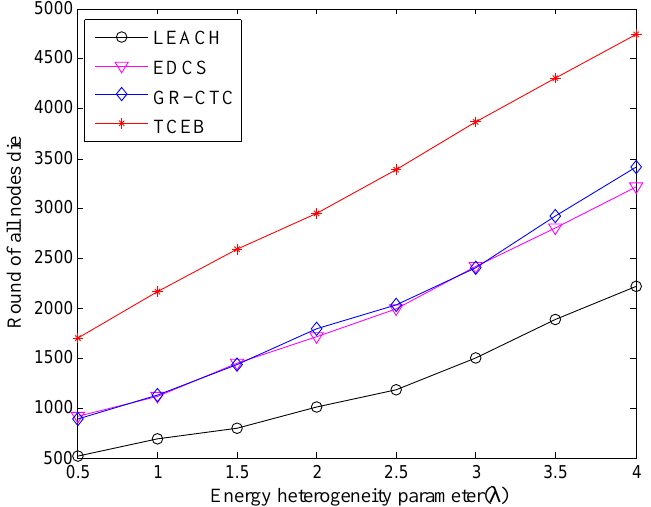
Figure 8. The comparison of whole lifetime under different energy heterogeneity factor ( n = 100 )